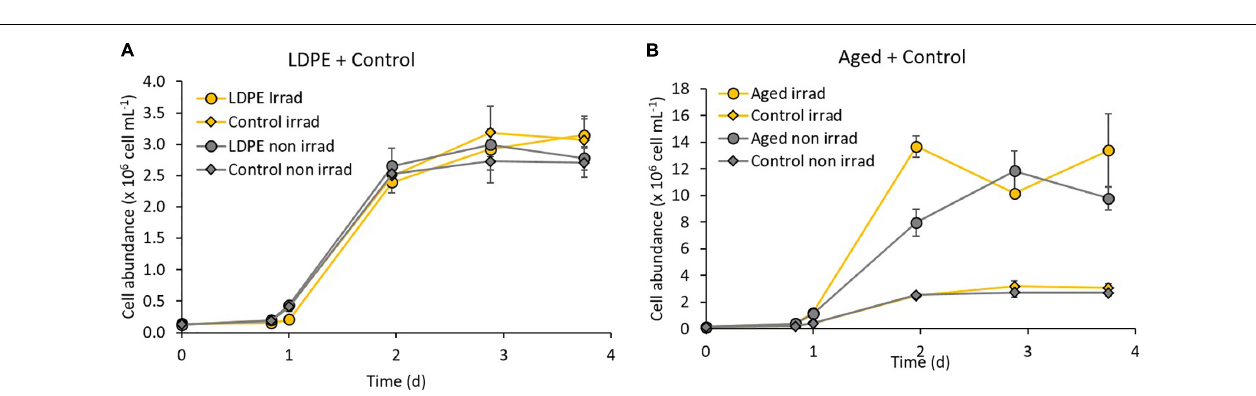
FIGURE 2 | Net Excitation Emission matrices (EEMs) variation in the leachates from aged plastic, as the difference between final and initial time points after (A) 6 days of abiotic irradiation; (B) 6 days of abiotic incubation with no irradiation; (C) 4 days of biodegradation by a marine natural community of the irradiated leachates; and (D) 4 days of biodegradation by a marine natural community of the non-irradiated leachates. Note the difference in the color scale for the irradiated and non-irradiated treatments.